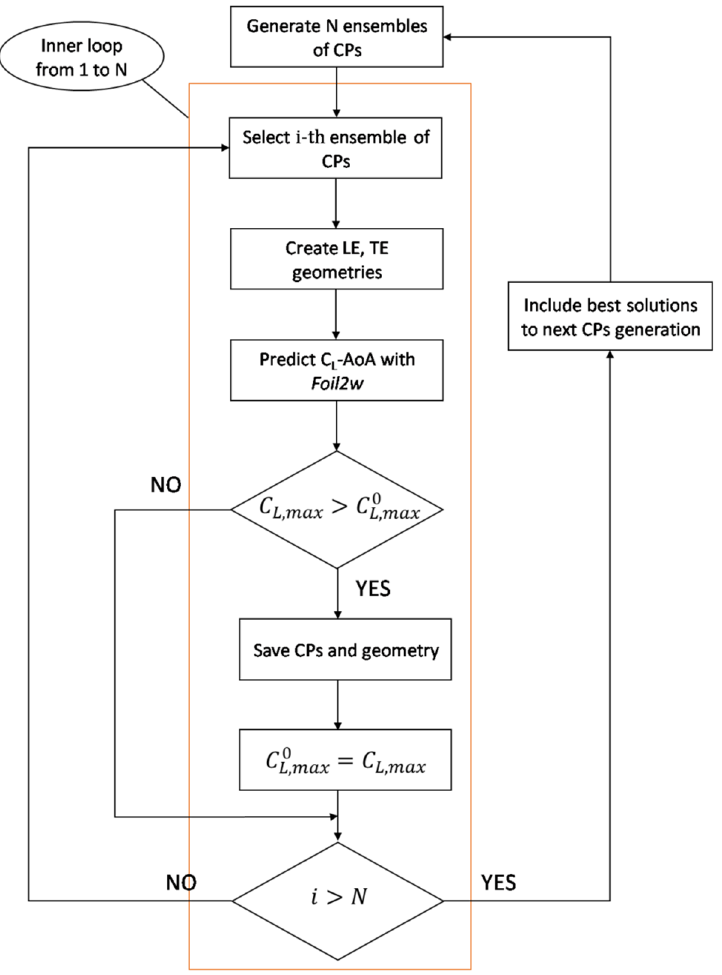
Figure 1. Flowchart of the optimization process. CP stands for Control Point. The superscript 0 on C L,max denotes the previous ensemble of CPs and geometry.